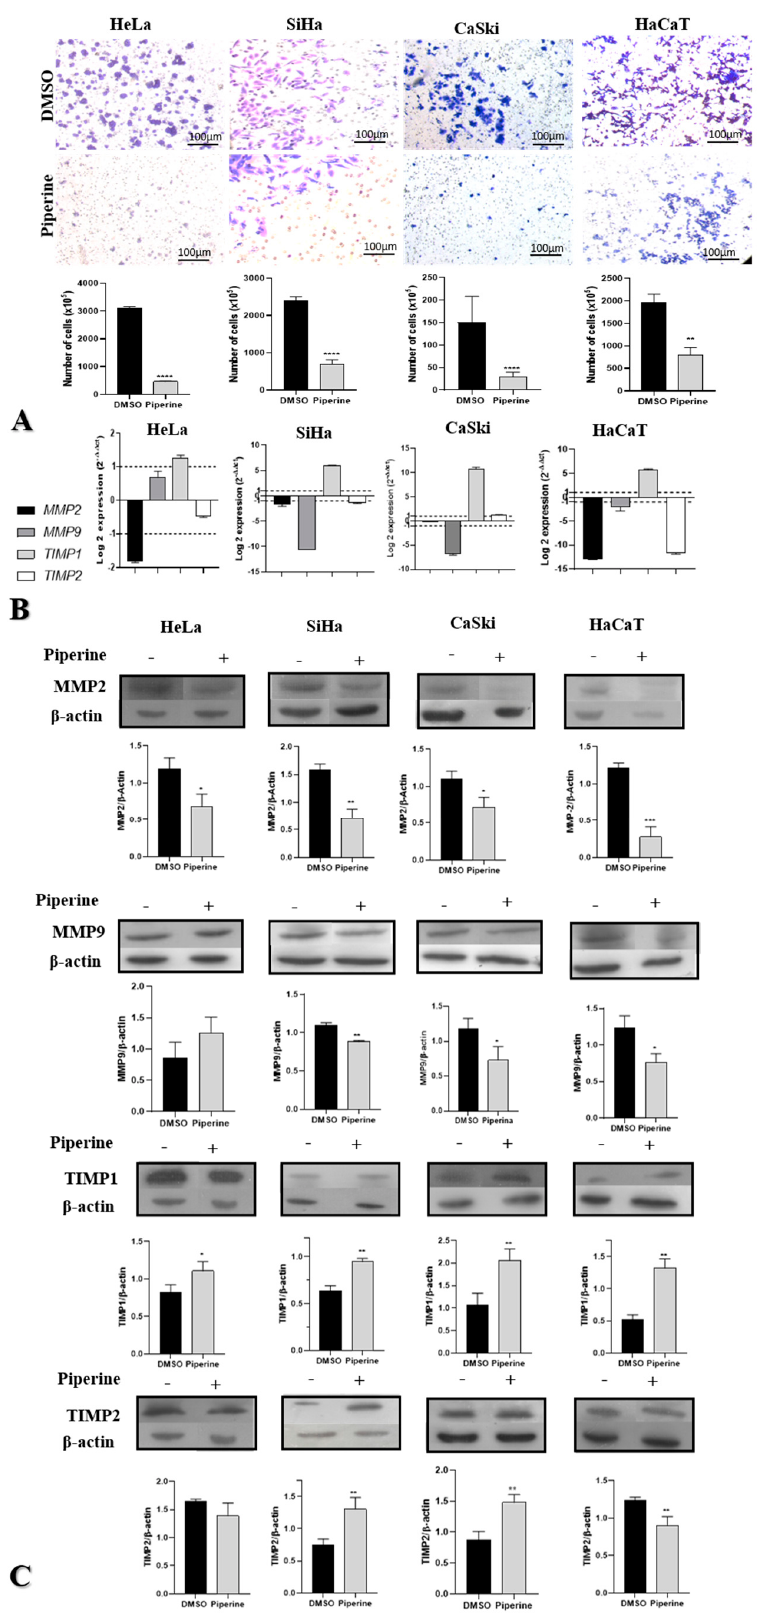
Figure 3. Piperine reduces cell migration in cervical cancer through the regulation of matrix metalloproteinases (MMPs) and their antagonists. ( A ) Photomicrograph of the migration of HeLa, SiHa,